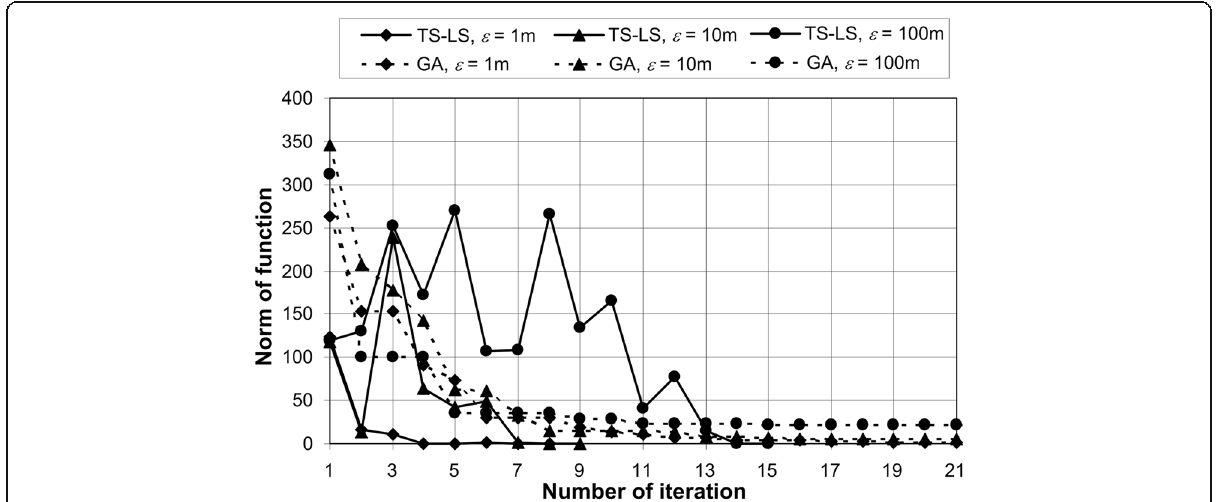
Fig. 7 Norm of navigation equation as a function of a number of iteration for a different